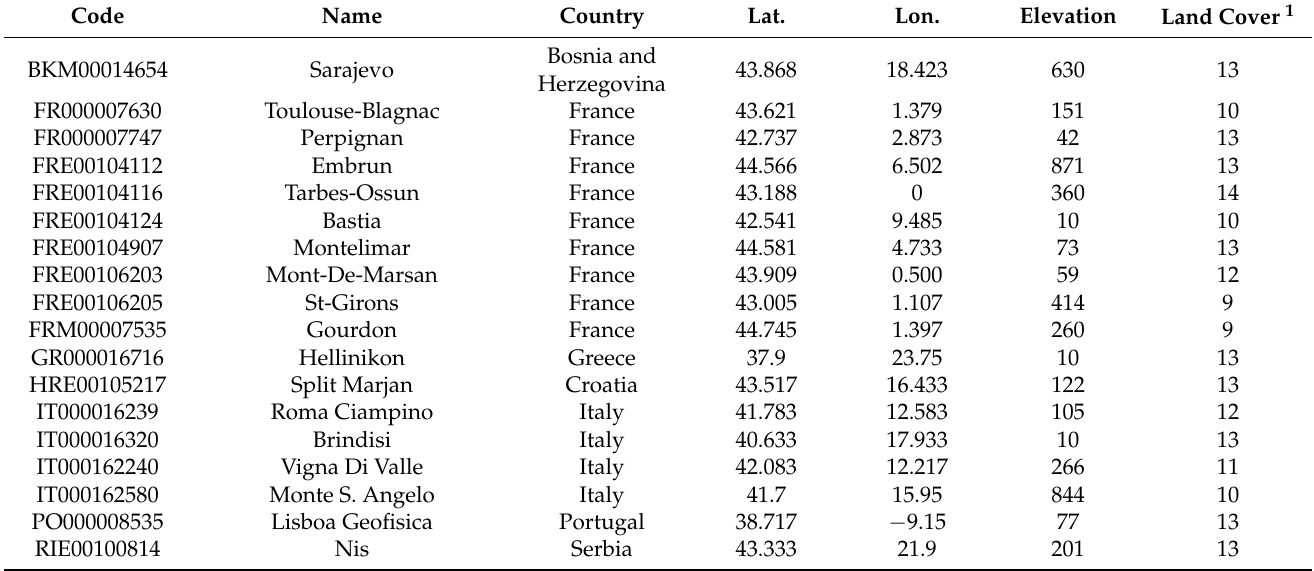
Table A1. Full list of the 58 weather stations from the GHCNd dataset used in this